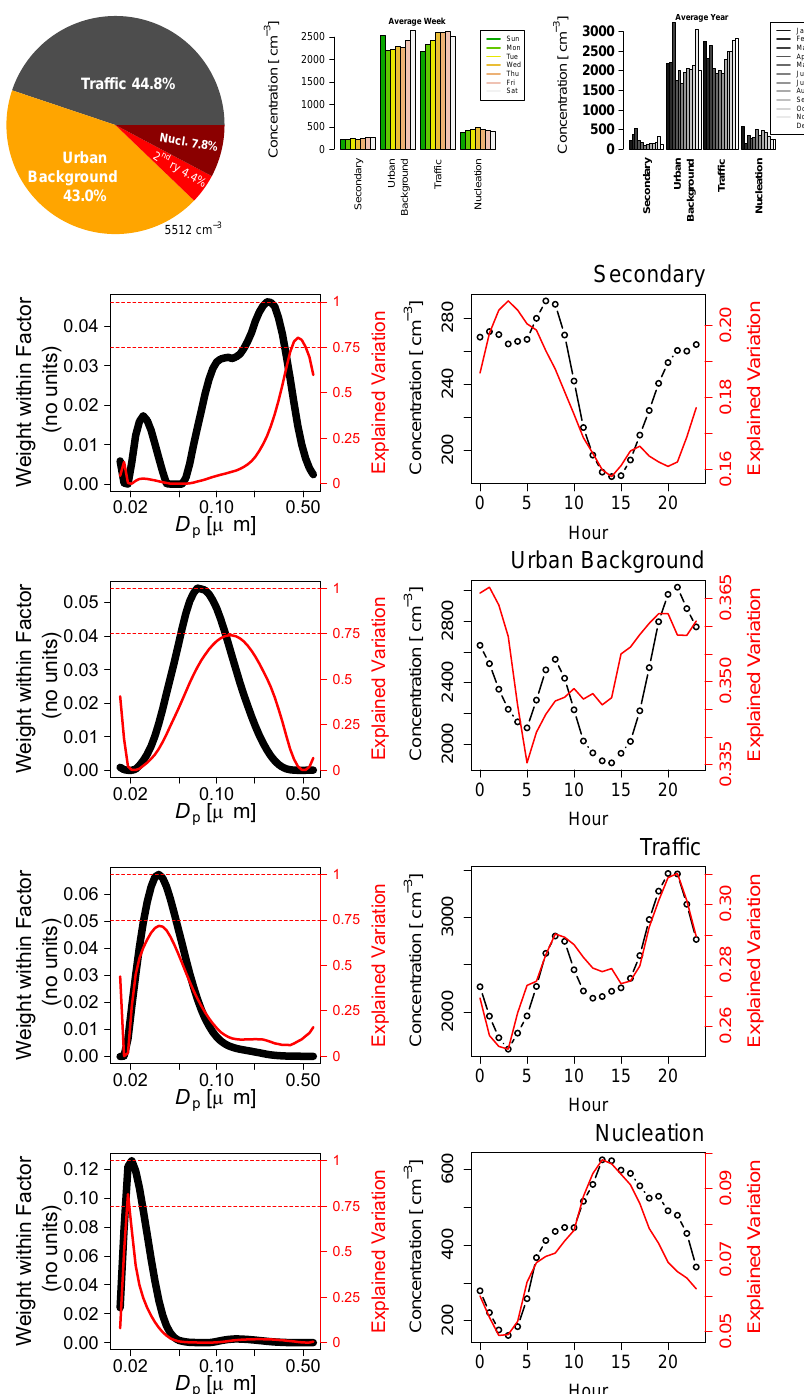
Figure 2. Factors outputted from PMF2 run on the particle number size distribution showing the contribution (black line) and explained variation of each metric (red